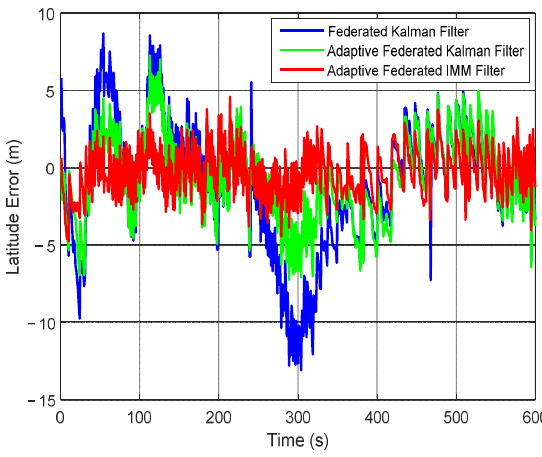
Figure 18. The estimation curves of latitude error.